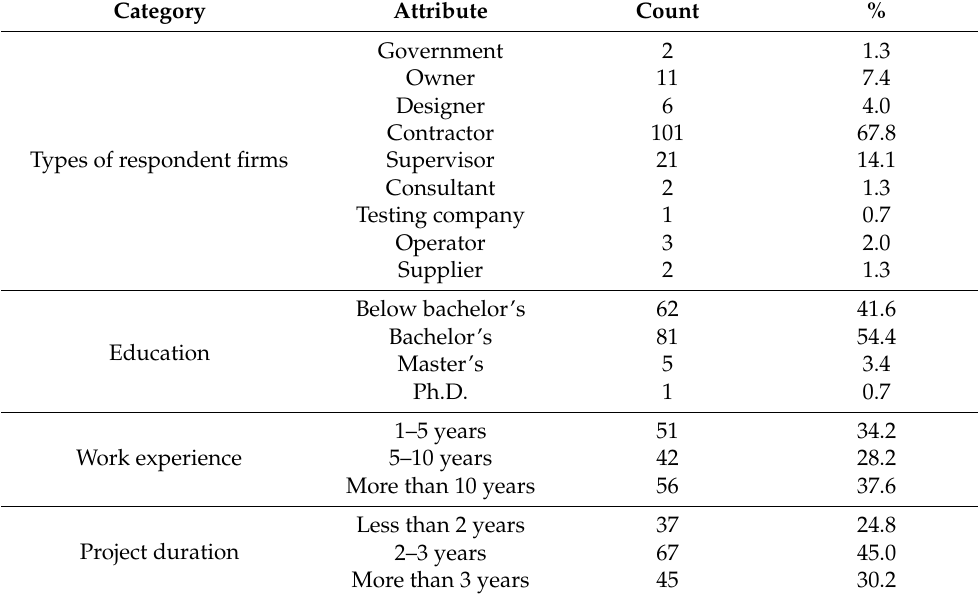
Table 2. Demographics of surveyed projects and